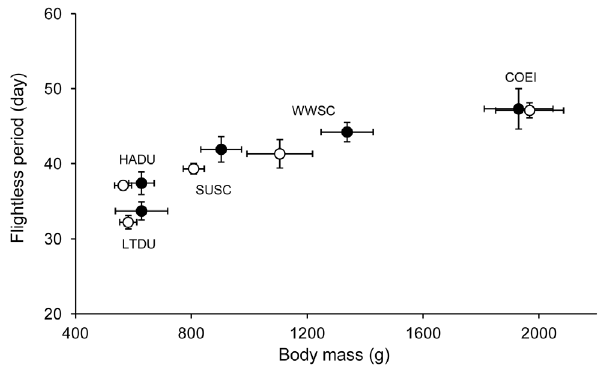
Figure 3. Relationship between body mass of 5 seaduck species and flightless period. Representation of the flightless period (days) according to the body mass for the 5 seaduck species (HADU, LTDU, SUSC, WWSC and COEI). Females are represented by white circles and males by black circles.